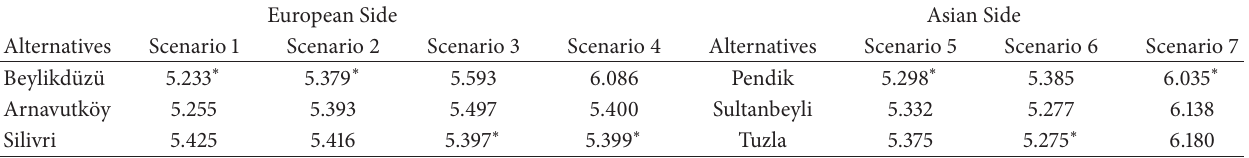
Table 13: The results of scenarios for both sides of Istanbul.